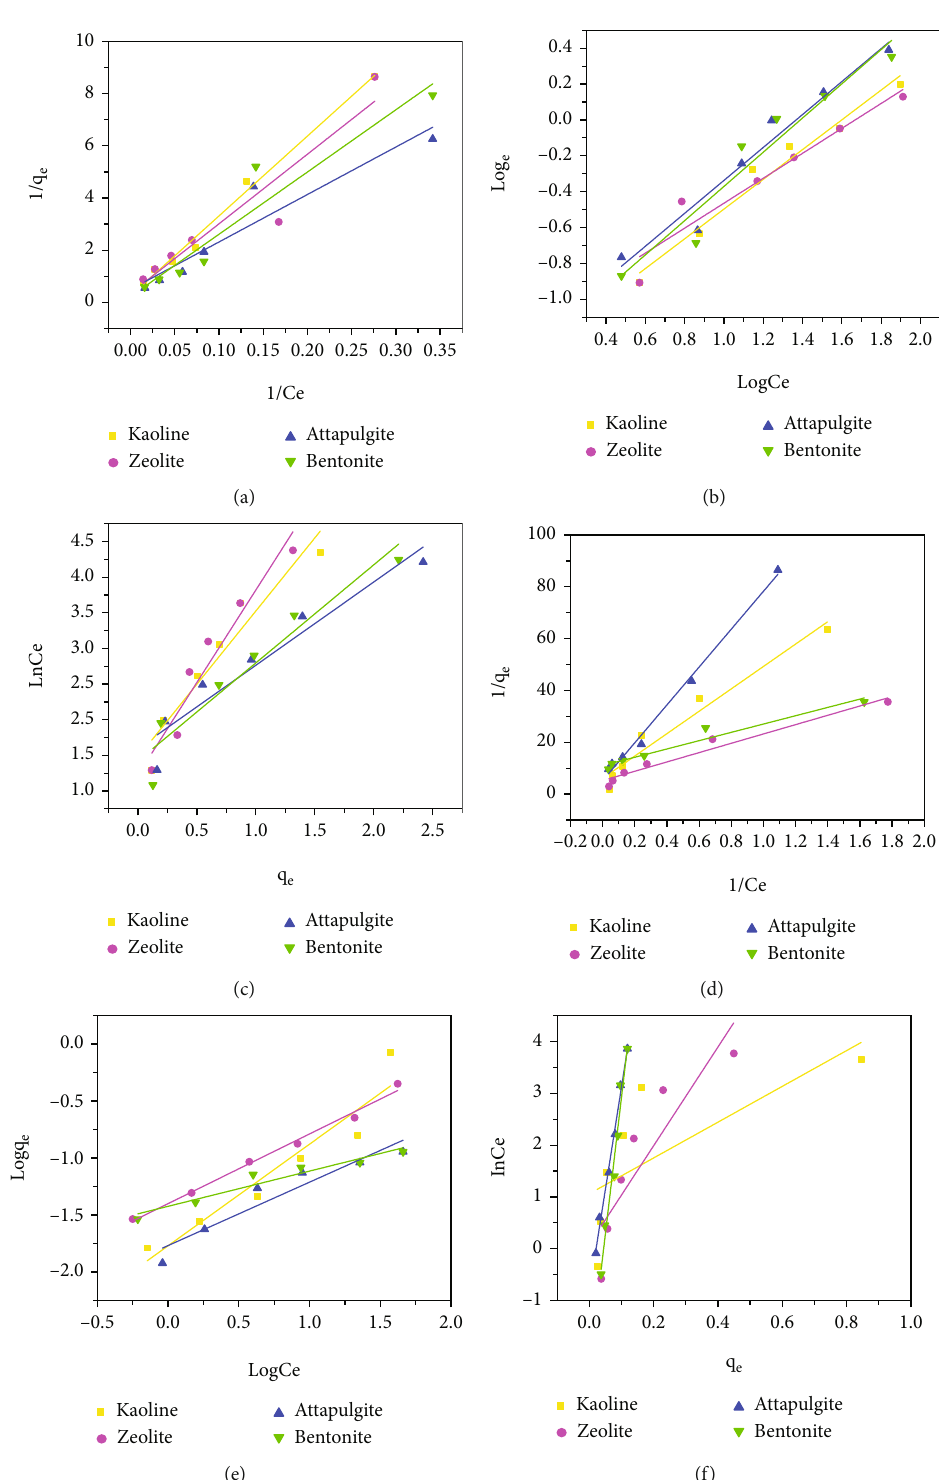
Figure 8: Three models for the adsorption of isotherms of NCMs on ammonia nitrogen ((a) Langmuir II model, (b) Freundlich model, and (c) Temkin model) and phosphate ((d) Langmuir II model, (e) Freundlich model, and (f) Temkin model). V = 25 mL , temperature at